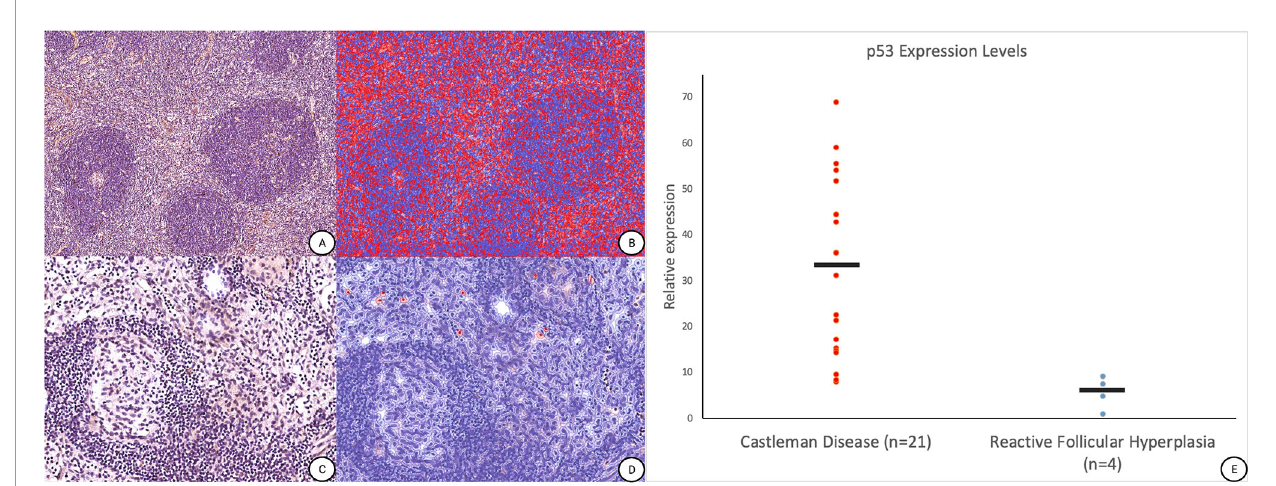
FIGURE 2 | p53 nuclear protein positive cell detection in Unicentric Castleman Disease. (A) Representative p53 immunohistochemical stain performed on additional UCD cases (magni fi cation ×100). (B) Post cell detection image from QuPath illustrating the presence of p53 nuclear protein overexpression[red] versus background negative cells [blue] (magni fi cation ×100). (C) Representative p53 immunohistochemical stain performed on an internal “ control ” case of reactive hyperplasia (magni fi cation ×200). (D) Post cell detection image from QuPath illustrating the presence of p53 nuclear protein overexpression[red] versus background negative cells [blue] (magni fi cation ×200). (E) Dot plot of p53 nuclear expression levels within UCD normalized to cases of reactive follicular hyperplasia. Of note, prospective clinical analysis showed that an additional 15 cases of reactive lymph nodes displayed a relative expression of 10 or less on p53 on staining (data not